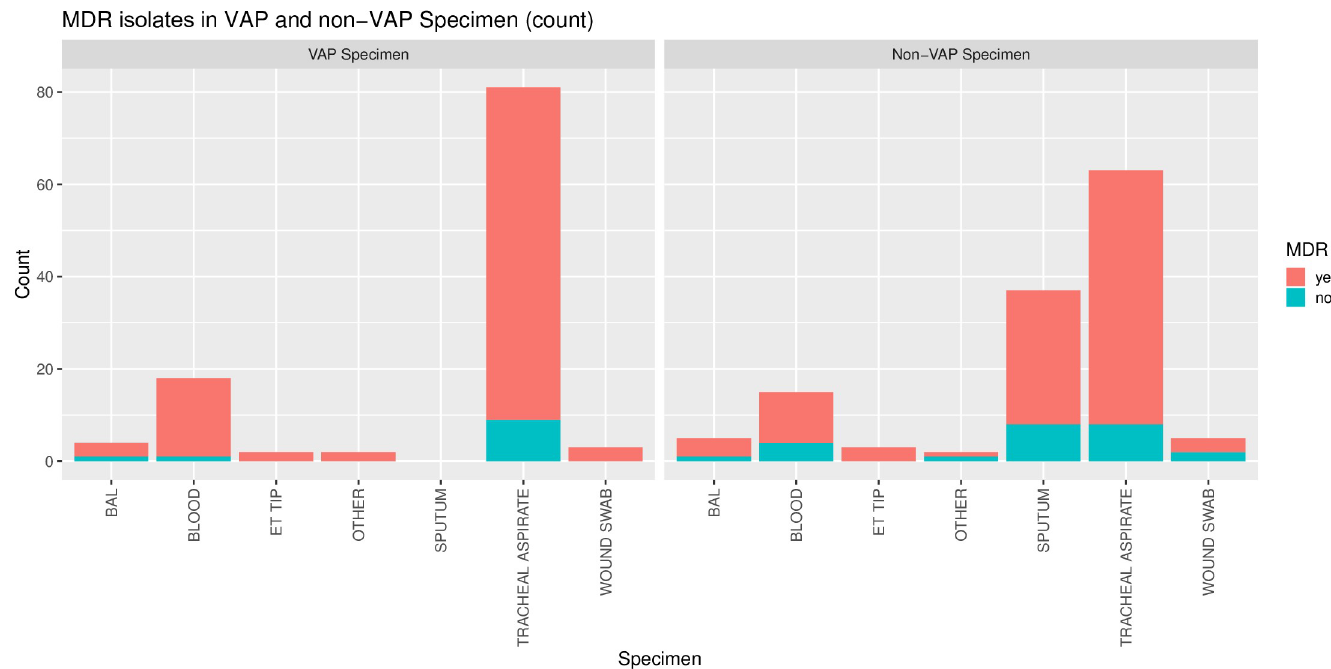
Fig 5. MDR isolates in VAP and non-VAP specimen.